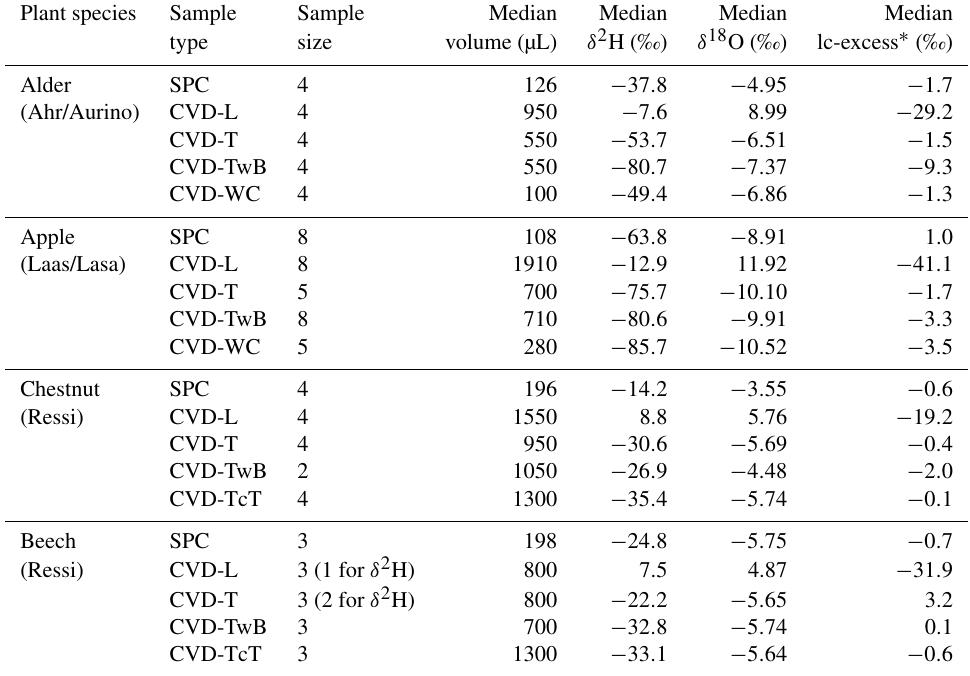
Table 1. Sample size, median sample volume, median isotopic composition, and median lc-excess ∗ of the samples extracted by Scholander- type pressure chamber (SPC) and cryogenic vacuum distillation (CVD) from different plant tissues (L: leaves; T: twig without bark; TwB: twig with bark; WC: wood core; TcT: twig close to the trunk) and species in the three study sites (Ahr/Aurino, Laas/Lasa and Ressi). Note that SPC samples consisted of lignified twigs with bark and leaves attached to the twig, and the reference comparison is between SPC and